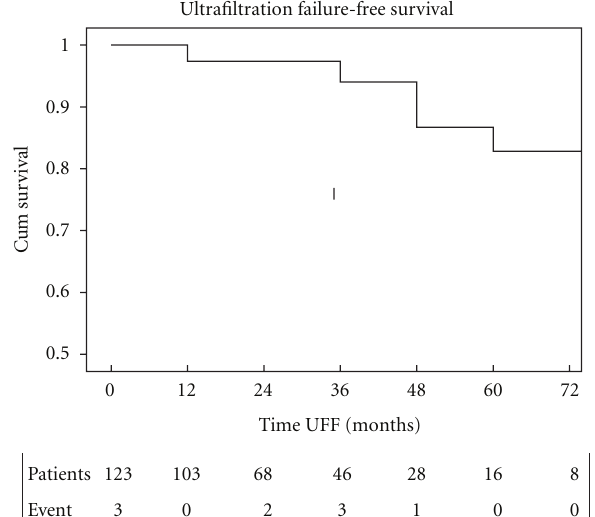
Figure 4: UFF-free survival rate was 97%, 87%, 83% at 1, 3, 5 years.